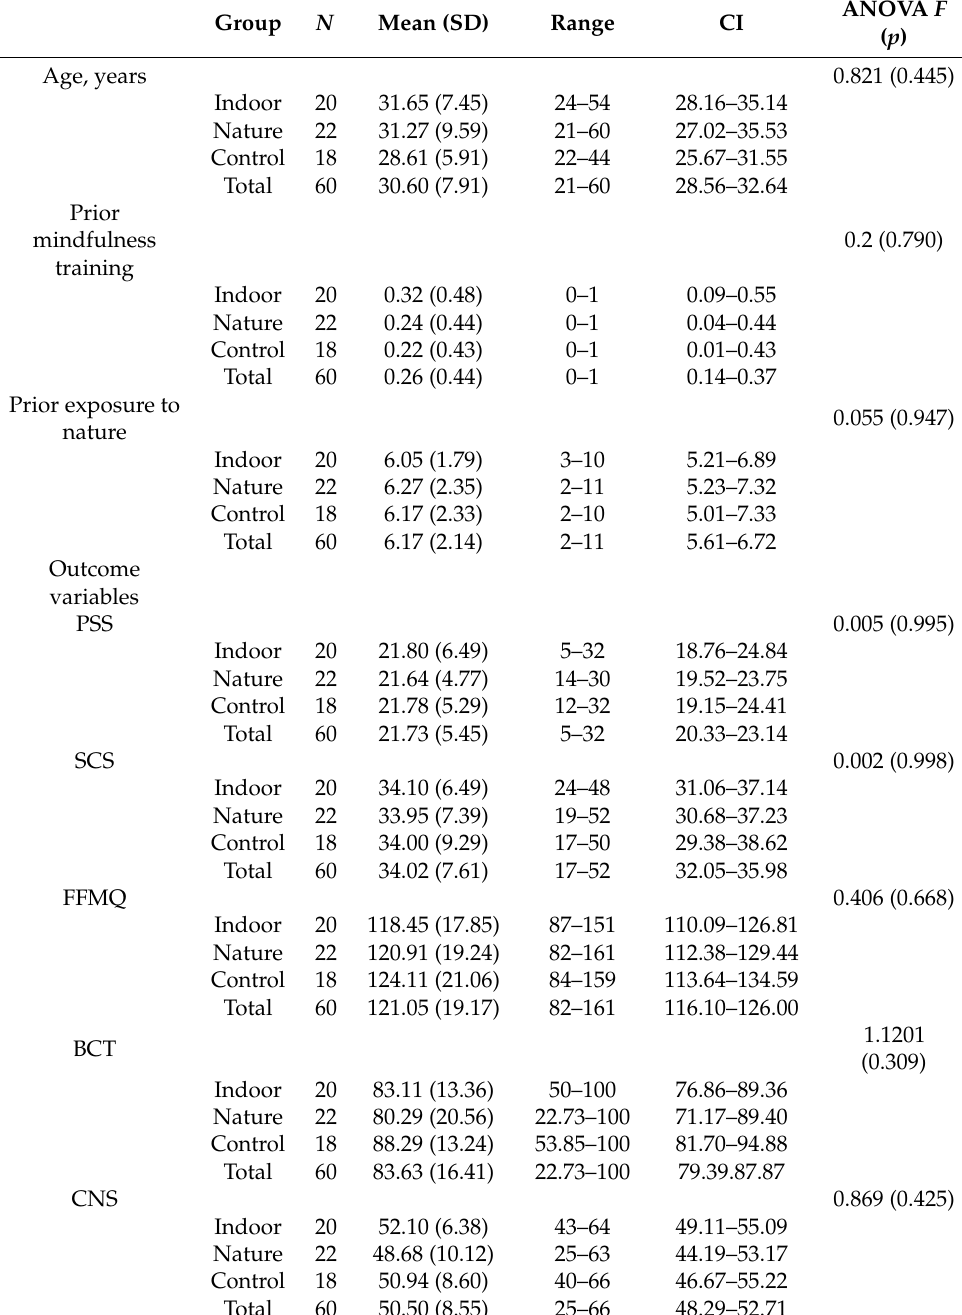
Table 3. Group descriptives and comparisons at